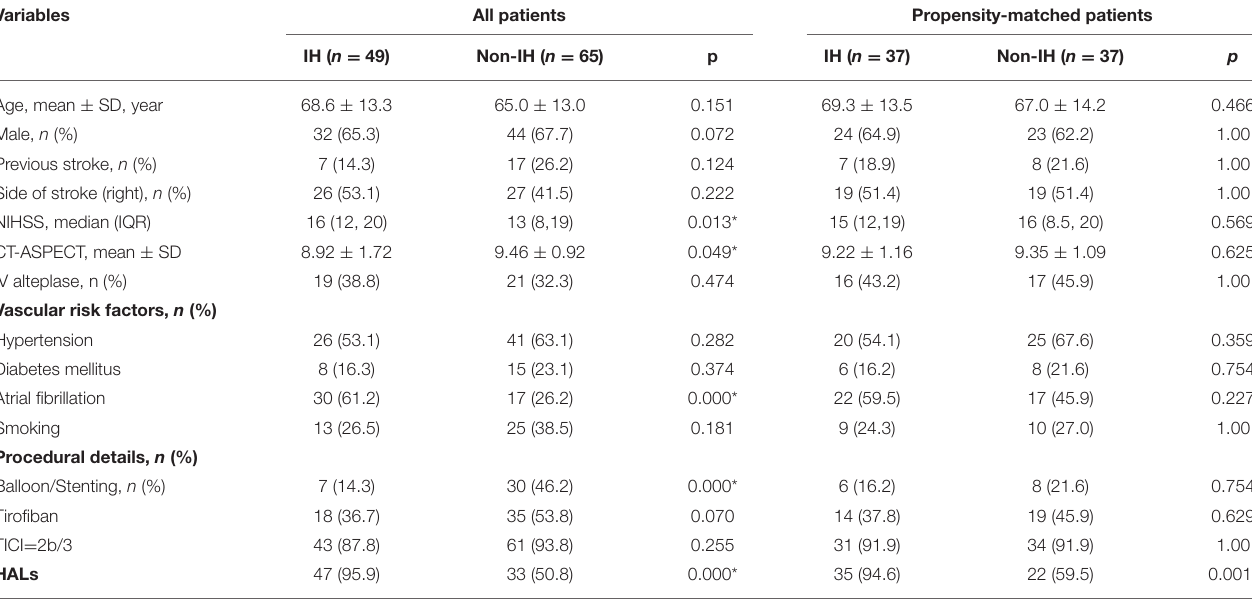
TABLE 1 | Baseline clinical characteristics according to IH. Variables All